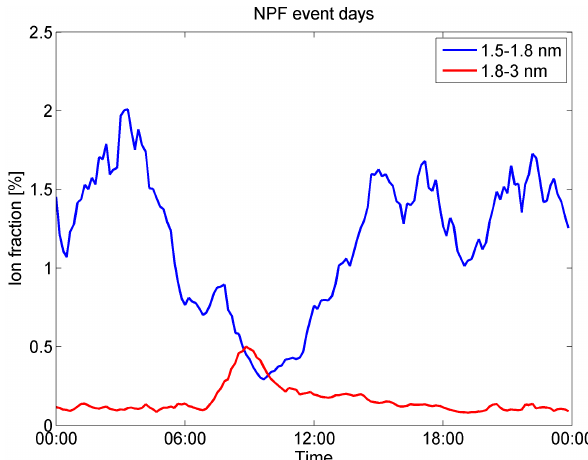
Figure 7. The median diurnal variation of the fraction of ions of all clusters in the size bins of 1.5–1.8nm (blue line) and 1.8–3.0nm (red line) on NPF event days. Time is UTC +